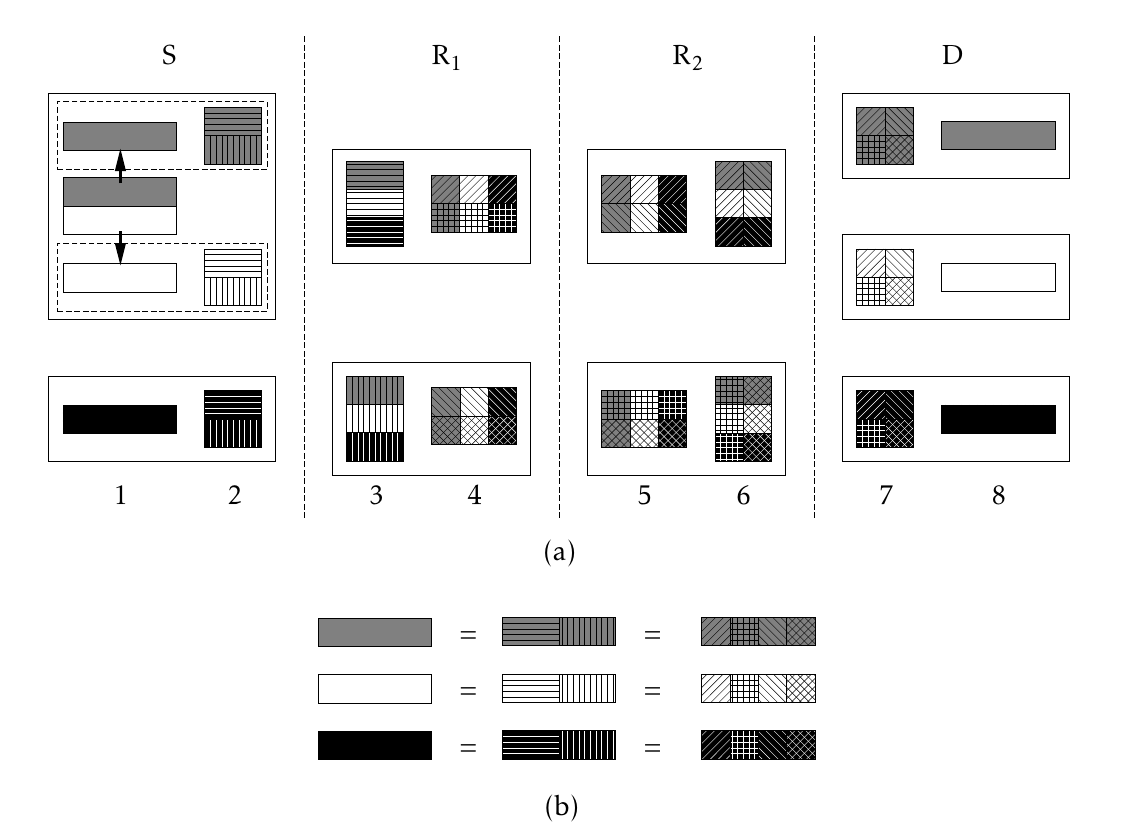
Figure 4. Demonstration of the message splitting processing. (a) Message processing steps: 1. original messages at layer S; 2. split and transmitted messages at layer S; 3. received and decoded messages at layer R layer R ; 5. received and decoded messages at layer R 1 messages at layer D; 8. reorganized orginal messages at layer D. (b) Message